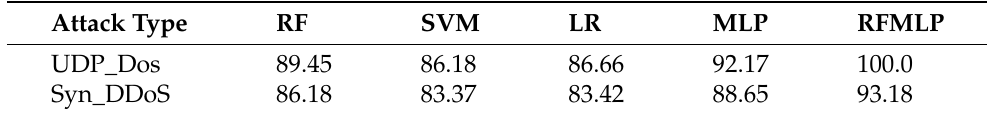
Table 7. Accuracy of classifiers on STIN satellite